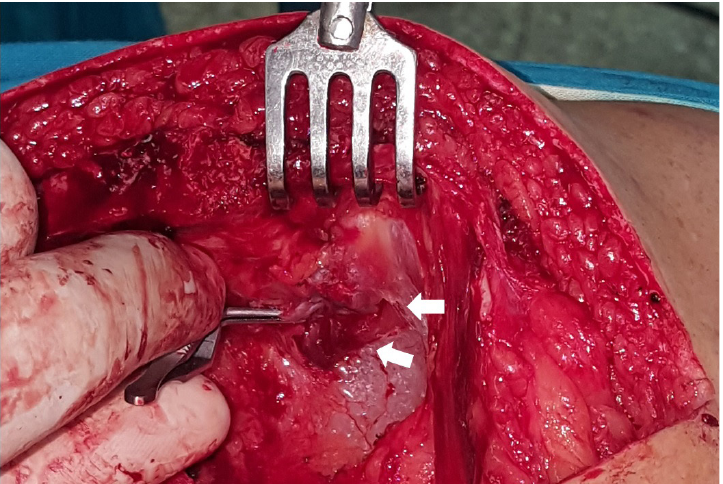
Fig. 2 -Detail of the left ITA dissection. The fibers of the transversus thoracis muscle that covered the distal segment of the artery were cut without bleeding (white arrows).